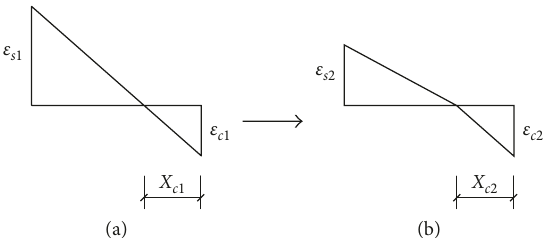
Figure 3: Average strain distributions in (a) bonded cross section and (b) unbonded cross